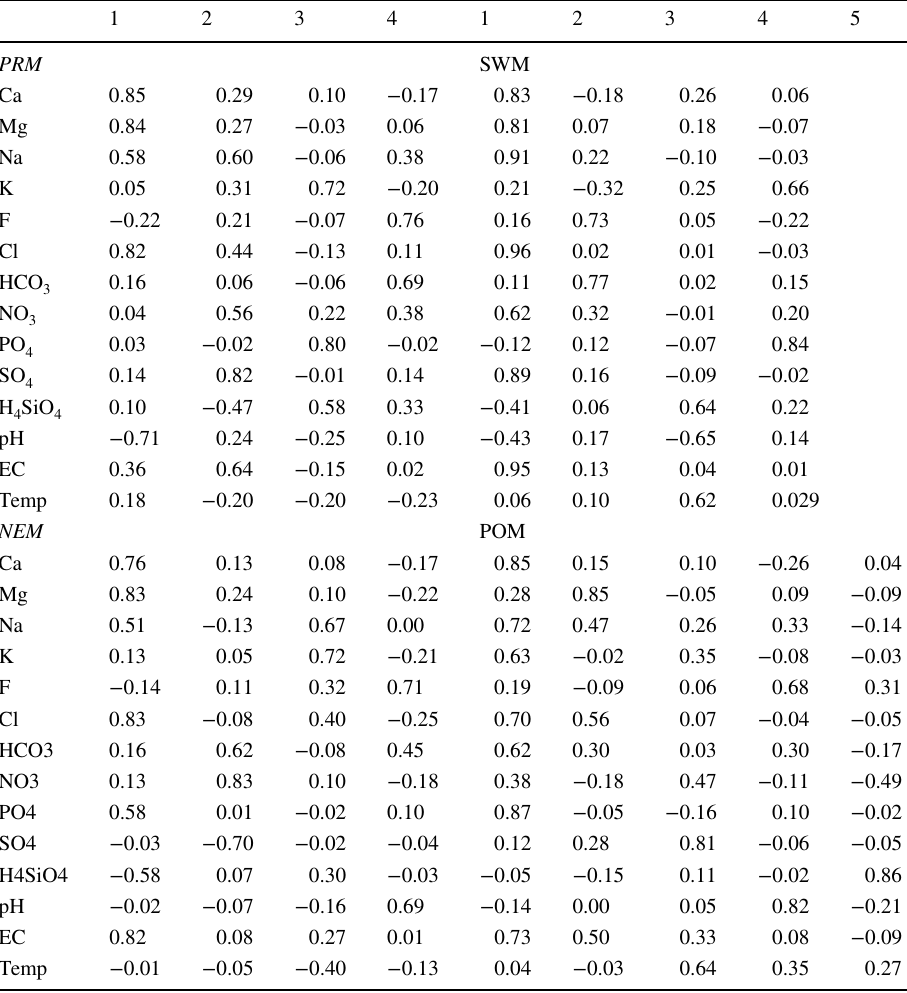
PRM, SWM, NEM and POM samples (Varimax